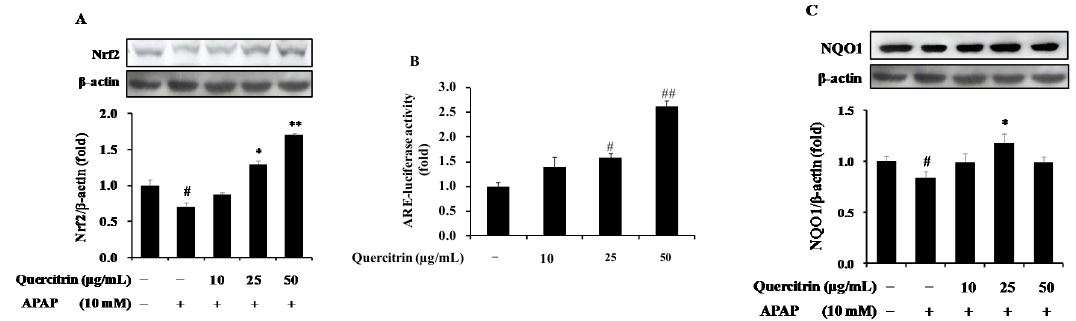
Figure 3. Up ‐ regulation of nuclear factor E2 ‐ related factor 2 (Nrf2)/antioxidant response element (ARE) ‐ mediated phase II detoxifying enzyme in APAP ‐ treated HepG2 cells. ( A ) Effect of quercitrin on protein expression of Nrf2; ( B ) Effect of quercitrin on ARE ‐ luciferase activity; ( C ) Effect of quercitrin on protein level of quinone oxidoreductase 1 (NQO1). Luciferase activity was normalized with total protein content and expressed as fold induction of normal control. Protein expression levels were normalized with β‐ actin. All data represent means ± SD of at least three independent experiments. Significant differences were ( ## ) p < 0.01 or ( # ) p < 0.05 as compared with the control; (**) p < 0.01 or (*) p < 0.05 as compared with APAP group.